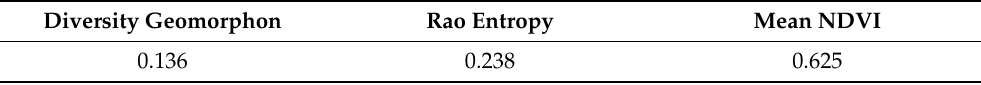
Table 3. Weights